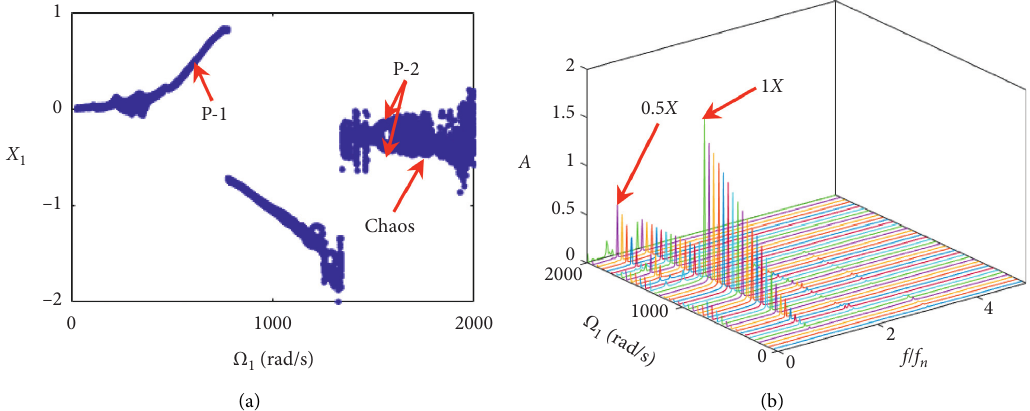
Figure 5: (a) Bifurcation diagram of the nondimensional displacement in x -direction X � 5 μ m, and k � 3 × 1016N/m3. (b) Waterfall plot of displacement responses under the same parameters e � 0.01mm, e � 0.01mm, c 0 1 c � 5 μ m, and k � 3 × 10 16 N/m 3 . 0 1